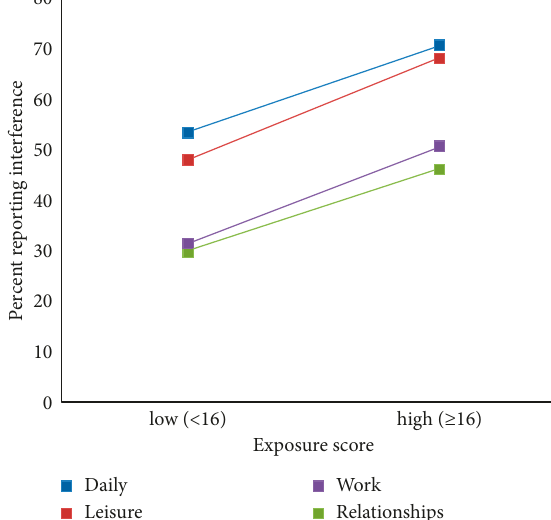
Figure 2: Percent of individuals reporting interference in the low- or high-exposure score groups. Daily OR 2.10 (95% CI 1.07–4.13). Leisure (cid:31) (cid:31) OR 2.23 (95% CI 1.14–4.36). Relationships (cid:31) (cid:31) that 53% of individuals in the low-exposure group and 71% of individuals in the high-exposure group reported that pain interfered with their daily